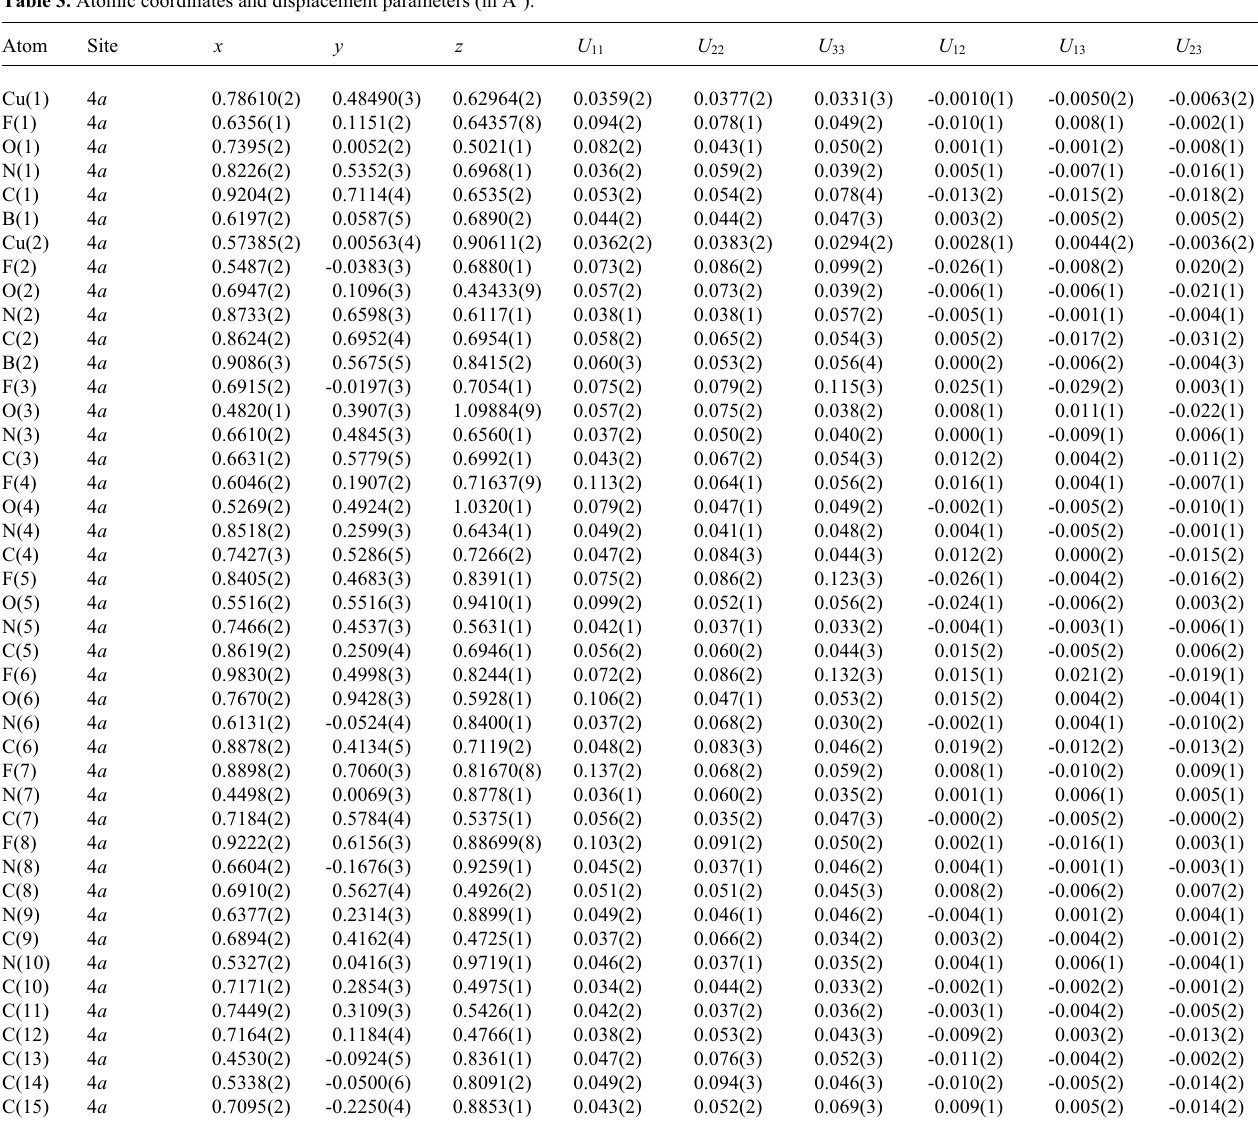
Table 3. Atomic coordinates and displacement parameters (in Å 2